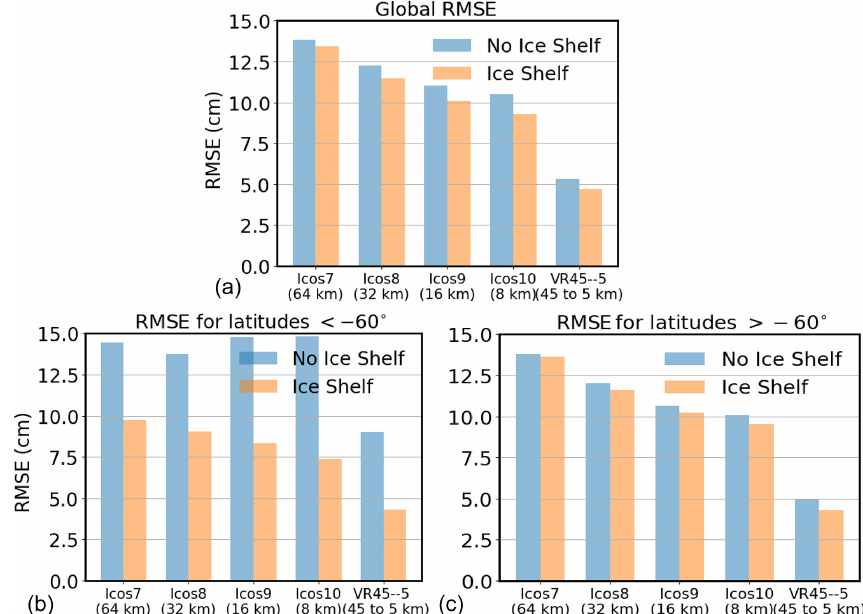
Figure 8. Error for the icosahedron 7, 8, 9 and 10 meshes, with and without ice shelf cavities for (a) the global RMSE, (b) RMSE at latitudes < − 60 ◦ and (c) RMSE at latitudes > − 60 ◦